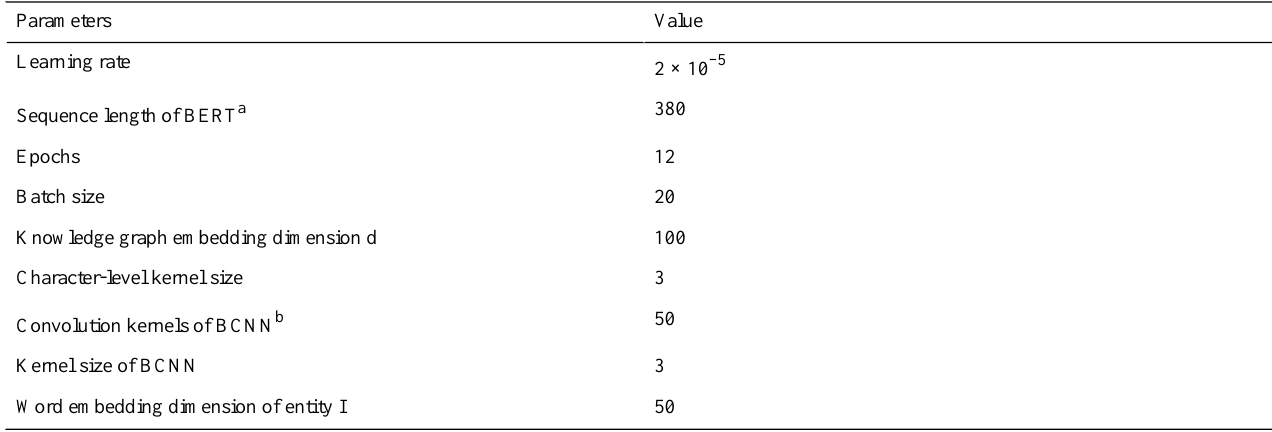
Table 2. Hyperparameters setting of our